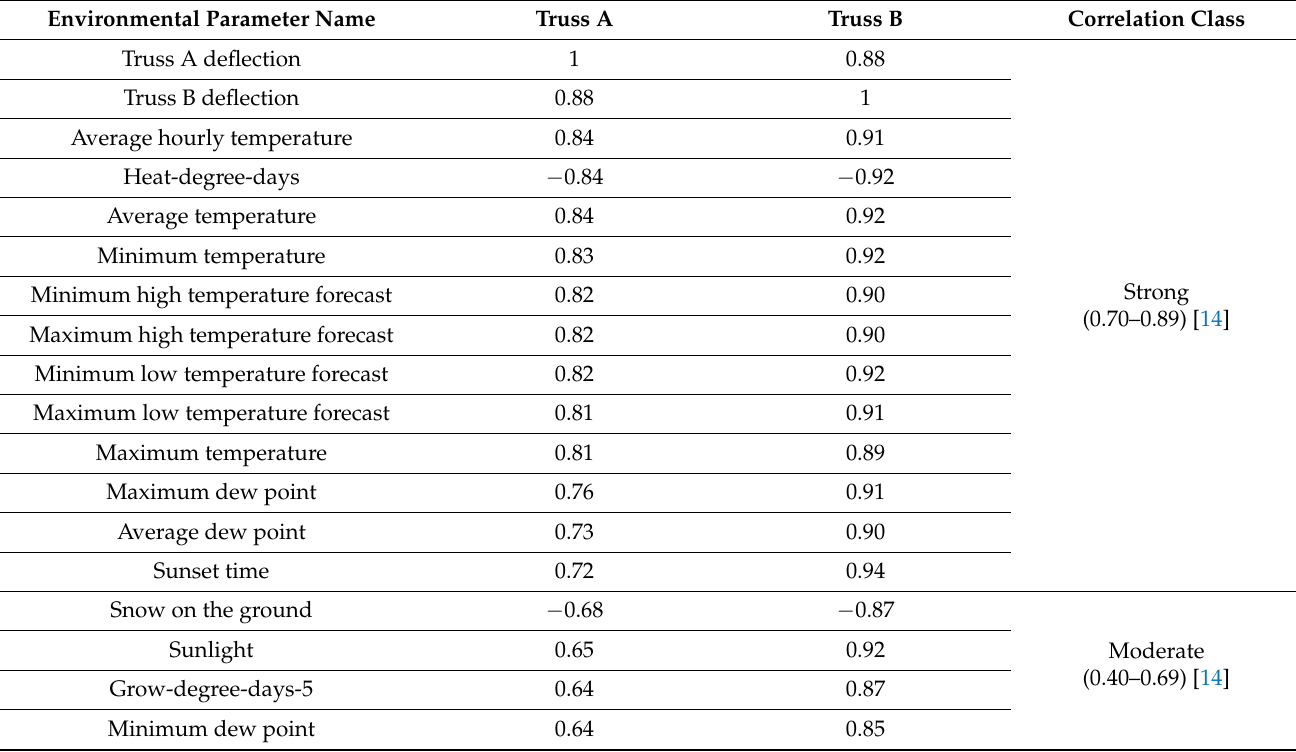
Table 2. Environmental parameters correlations with deflections. The results are sorted based on Truss A, and correlation class is assigned based on both